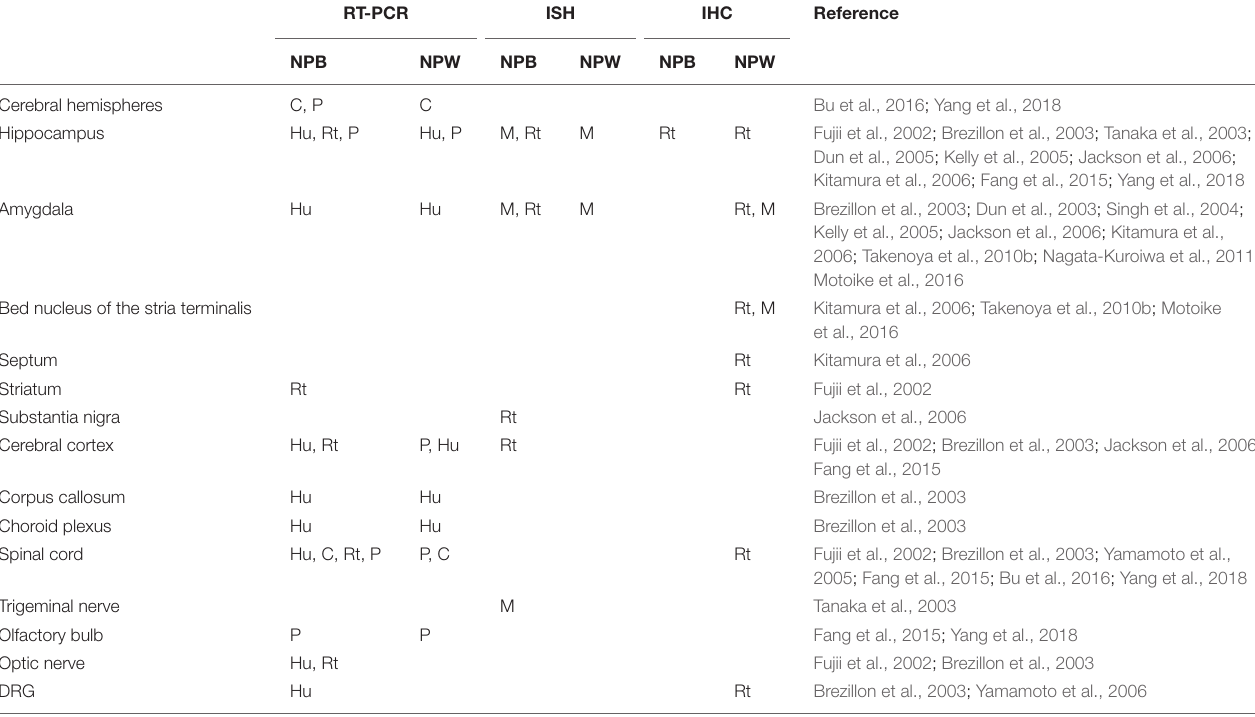
TABLE 1 | Localization of NPB and NPW in the telencephalon and peripheral nervous system. RT-PCR